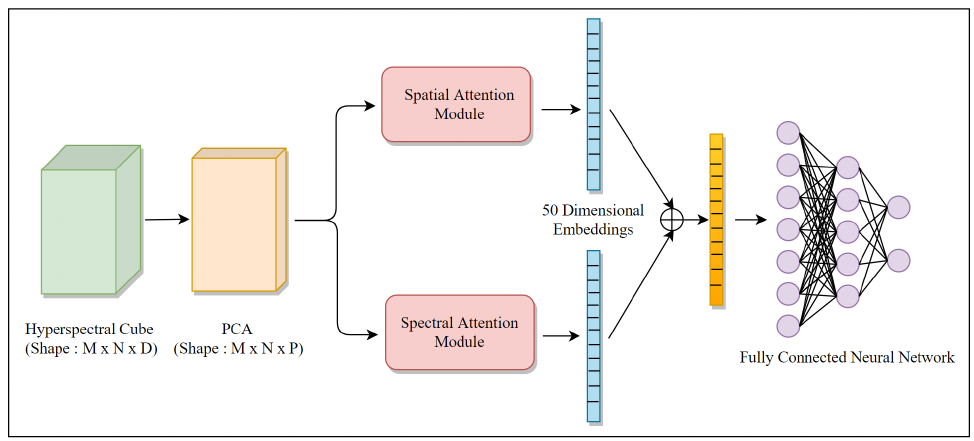
Figure 1. The proposed spatial-spectral attention-based classification framework (SPAT-SPEC-HYP-